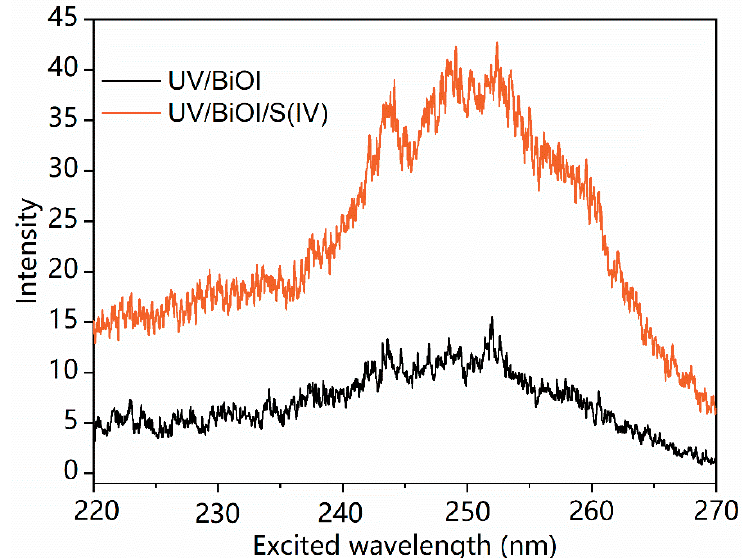
Figure 5. Fluorescence emission spectra for the UV/BiOI and UV/S(IV)/BiOI systems after reaction for 5 min. Conditions: [BiOI] 0 = 1.0 g · L − 1 (84.9 µ M as I); [S(IV)] 0 = 1.0 mM; [MCAA] 0 = 10 µ M; [DO] 0 = 0.22 mM (7.1mg · L − 1 ); pH = 7.0, 25 ± 1 ◦